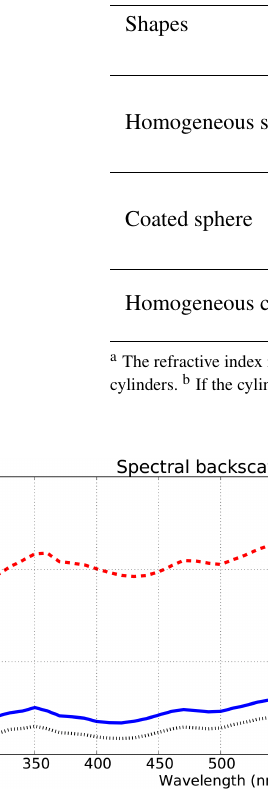
Figure 18. (a) Postulated and estimated refractive indices using the genetic algorithm for the equal-volume, spherical-shaped homogeneous particle and (b) the volume scattering function for the cylindrical-shaped particle. Table 2. Averaged relative errors for each method.